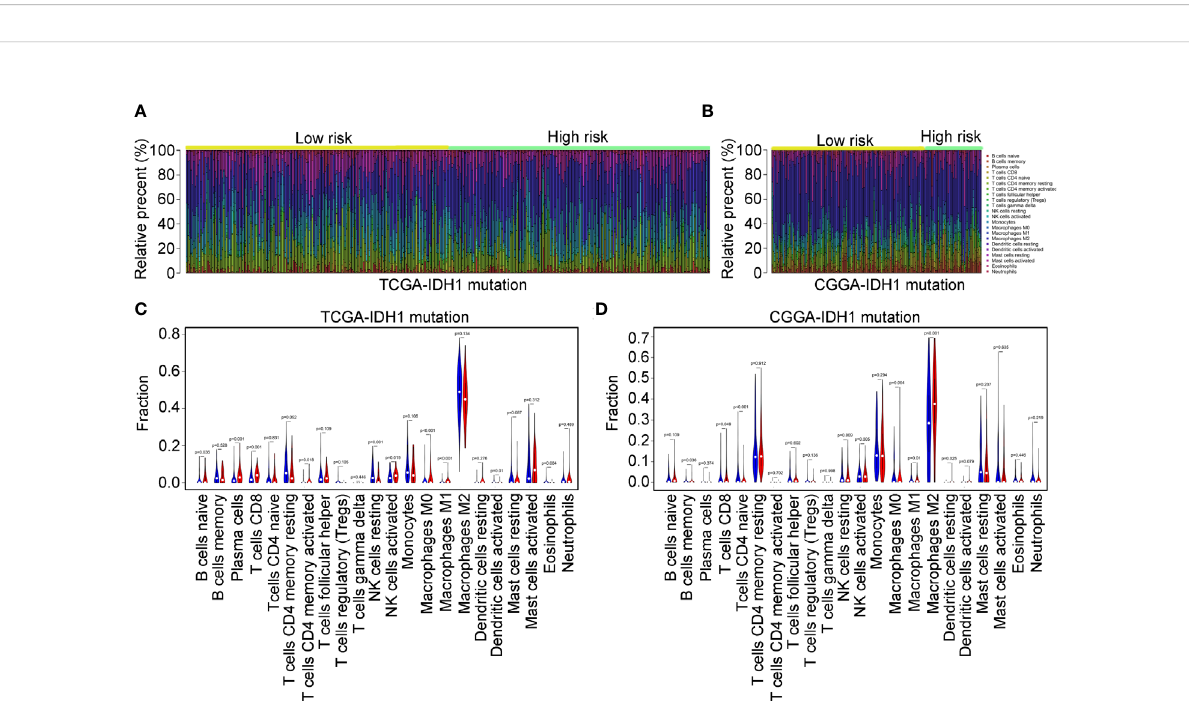
FIGURE 9 Immune characteristics of the three immune signatures. (A, B) The gene expression pro fi les of the high- and low-risk score group IDH1mt- glioma tissues in TCGA and CGGA were converted into 22 immune cell expression matrices. (C, D) Difference in immune cells between high- and low-risk score group IDH1mt-glioma tissues in TCGA and